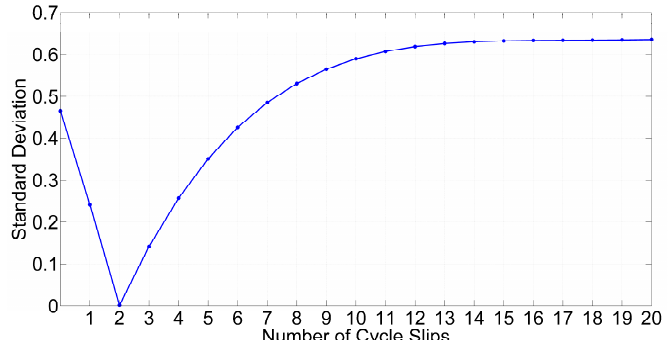
Figure 6. Standard deviations with different numbers of cycle slips at one epoch.